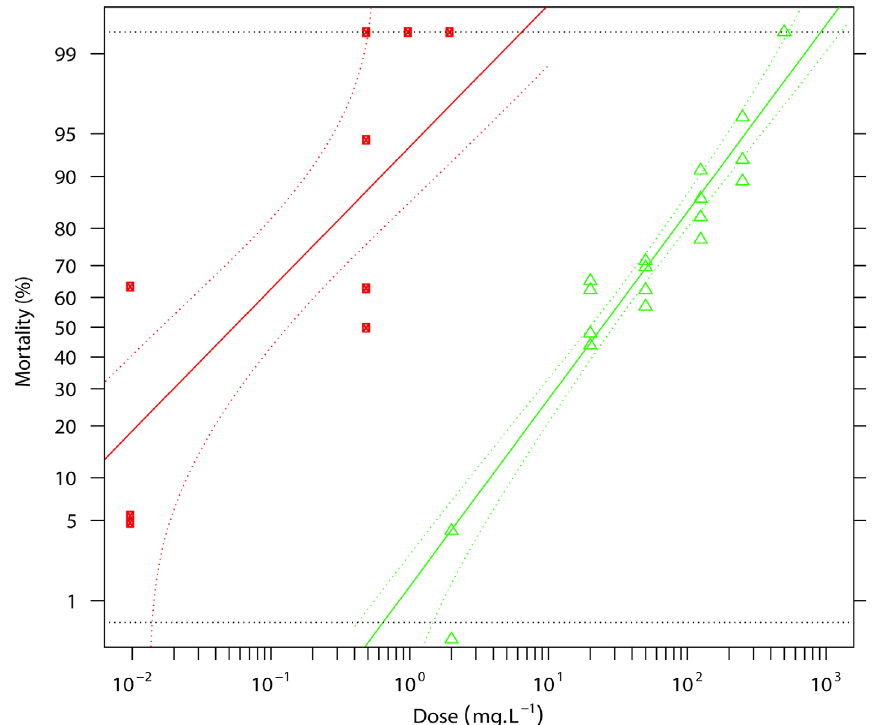
Figure 1. Regression line showing the mortality rates of the Kisumu and M’Bé strains to relative doses of alphacypermethrin. Red squares: Kisumu; green triangles: